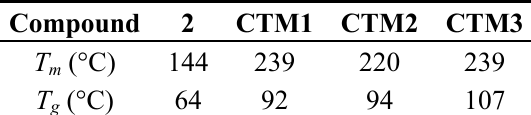
Table 1. Thermal parameters of CTM1 – 3